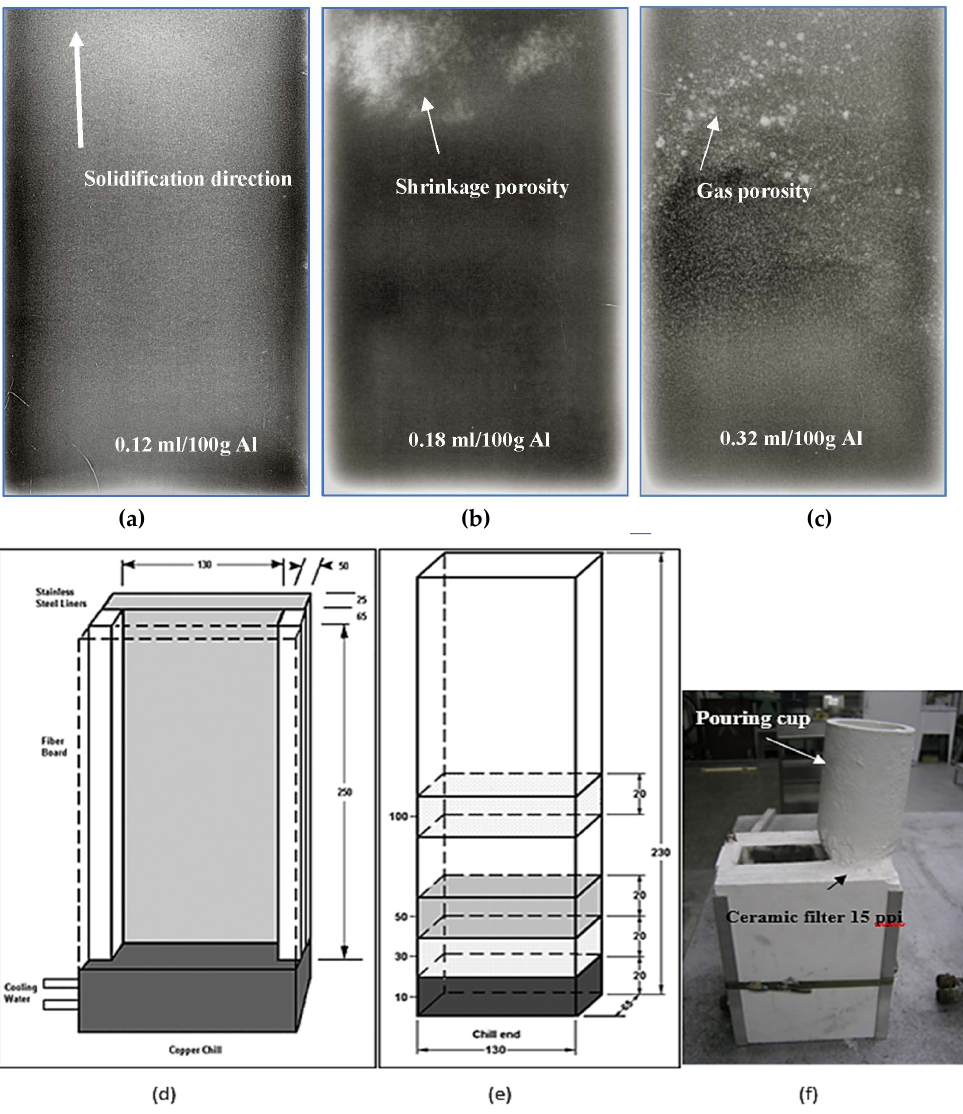
Figure 5. ( a – c ) Radiographic images of porosity distribution at different H 2 levels: ( a ) 0.12, ( b ) 0.18, ( c ) 0.22 mL/100 g Al, ( d,e ) schematic diagram (all dimensions are in mm), ( e ) actual mold configu- ration, and ( f ) typical casting.